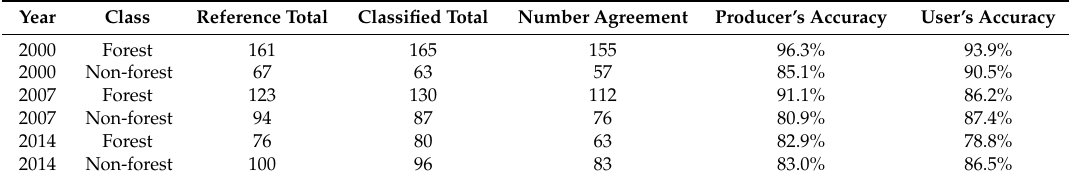
Table 2. Forest map validation. Validation was done with points visually interpreted using Landsat imagery from the 2000, 2007, and 2014 NDVI-derived forest maps. Areas are classified as forest or non-forest. Overall accuracy using this approach was 93.0%.